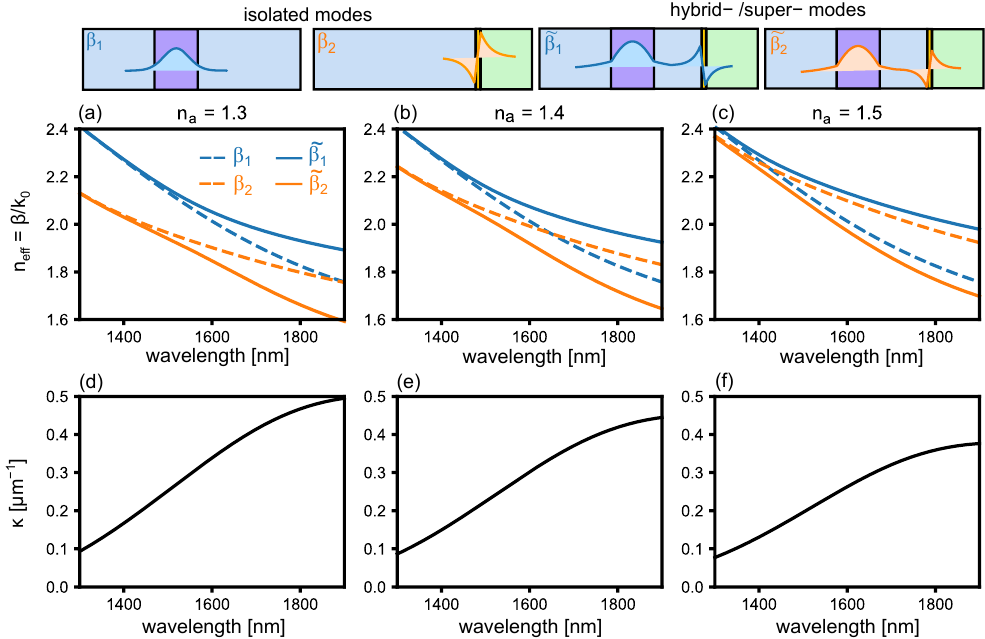
Figure 3. Effective index n eff = β / k 0 as a function of wavelength for the geometry shown in Figure 2 when ( a ) n a = 1.3, ( b ) n a = 1.4, ( c ) n a = 1.5 in the lossless case. The dashed line shows the isolated plasmonic- and dielectric- modes, respectively. The solid lines show the hybrid eigen- modes. ( d – f ) show the associated calculated coupling coefficients, following the simple expression in Equation (8) (black line). Top row shows a schematic of the magnetic field for the plotted isolated- or